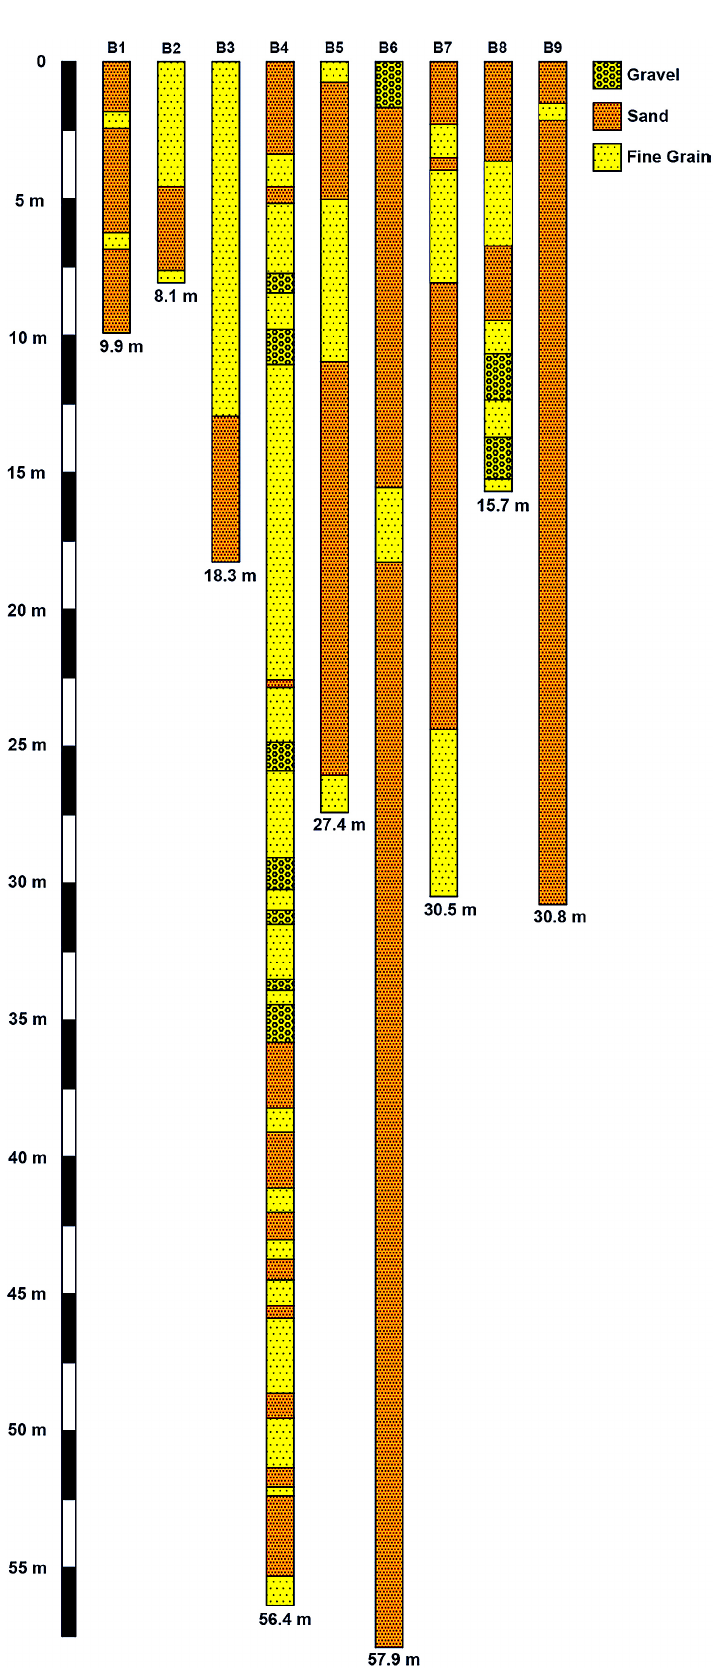
Figure 12. Lithological logs in the interest area.